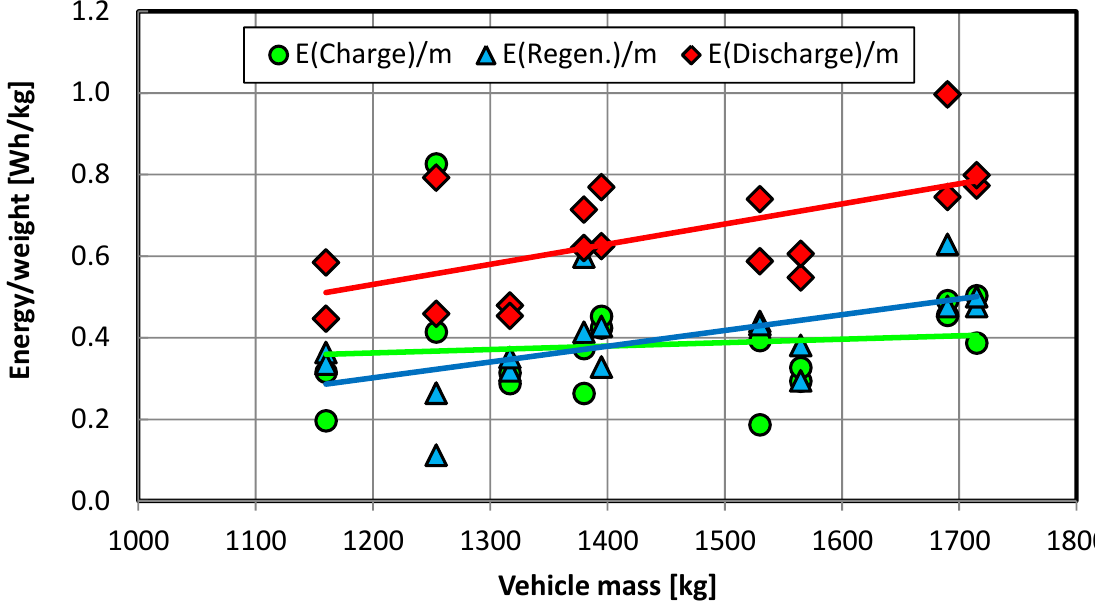
Figure 10. Correlations of specific energy: charging, discharging and regeneration to vehicle mass.